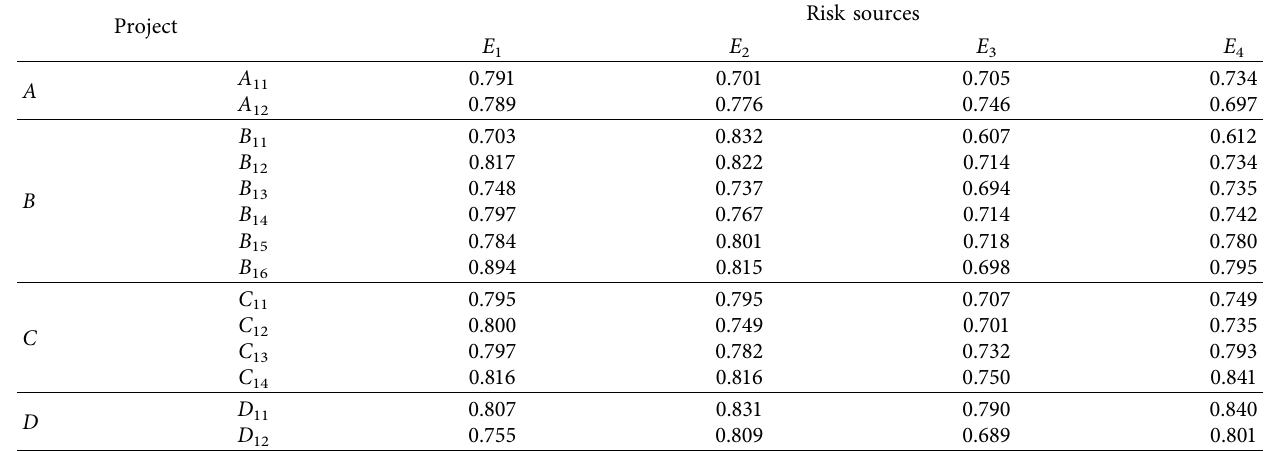
Table 7: Risk source score table for the lower part of the Yinzhou lake bridge.